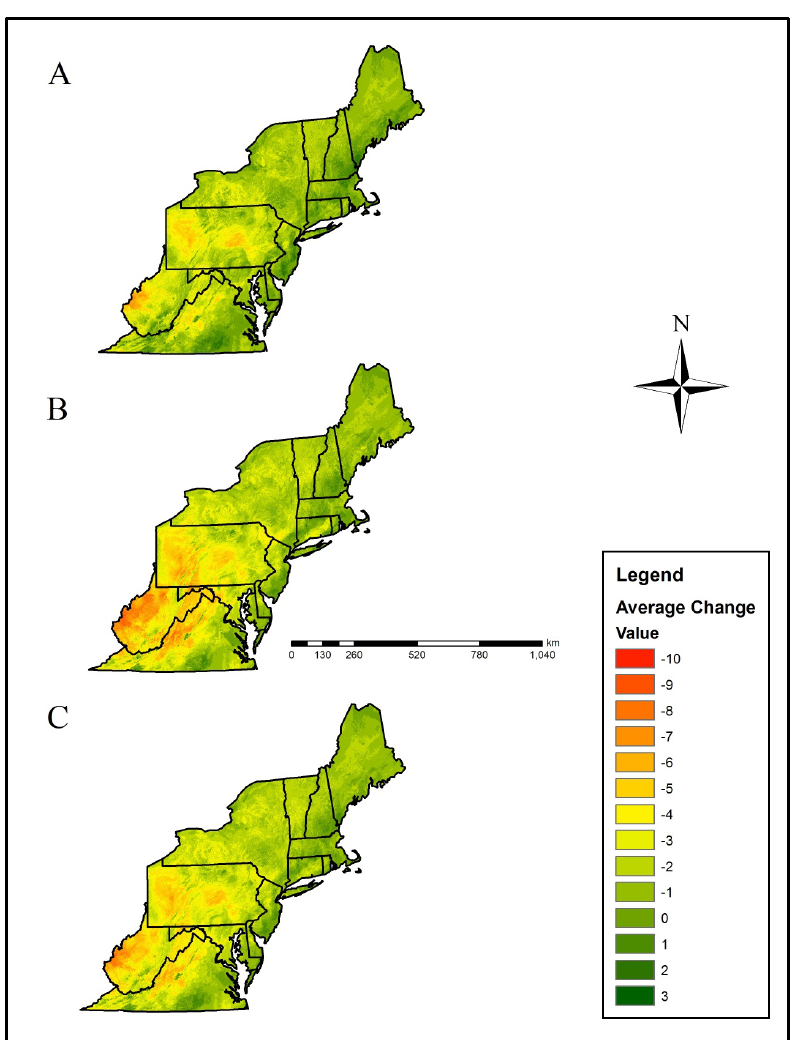
Figure 5. Mean loss in salamander climatic refugia richness ( i.e. , number of species with a climatically-suitable niche in a landscape patch) based on two Global Climatic Models (CCSM4 (CCSM) and HadGEMCC-2 (Hadley)). Our results were averaged across Representative Concentration Pathways (RCP), including the ( A ) RCP 4.5, ( B ) RCP 8.5, and ( C ) overall RCP average. Negative values correspond with a loss in climate refugia richness compared to the current climatic